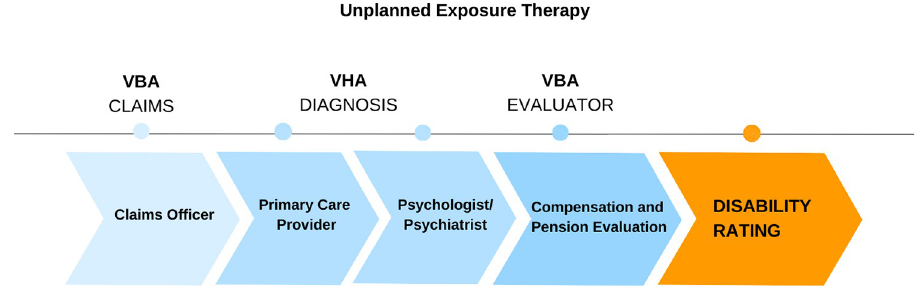
Fig 1. The recounting of trauma in the VA disability claims